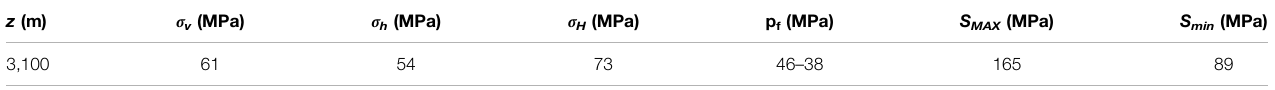
TABLE 3 | Field data in the Ichthys fi eld, Browse Basin.